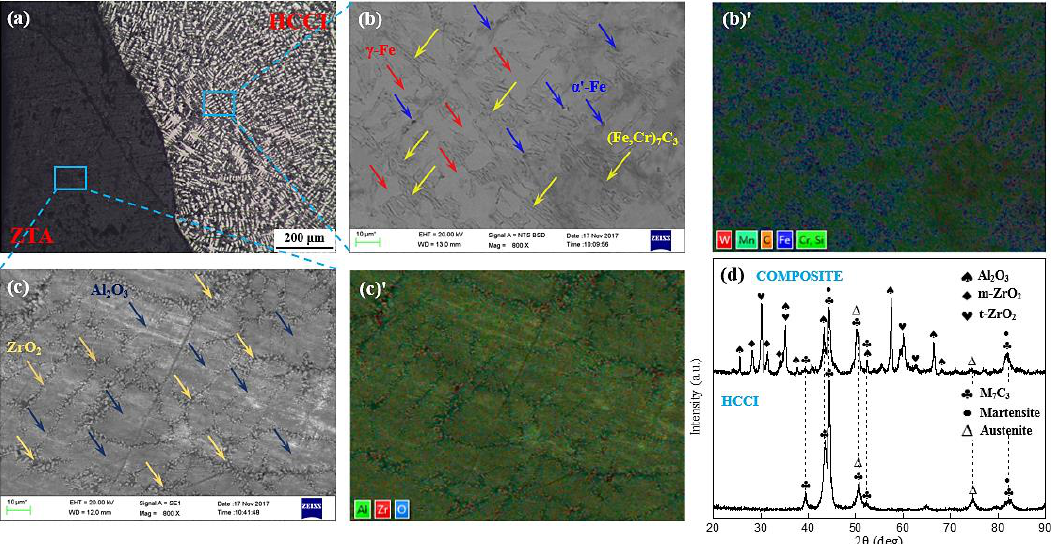
(cid:48) ) Microstructure of the composite; ( d ) XRD analysis result of the Figure 4. ( a )–( c ) Microstructure of the composite; ( d ) XRD analysis result of the composite. Figure 4. ( a – c